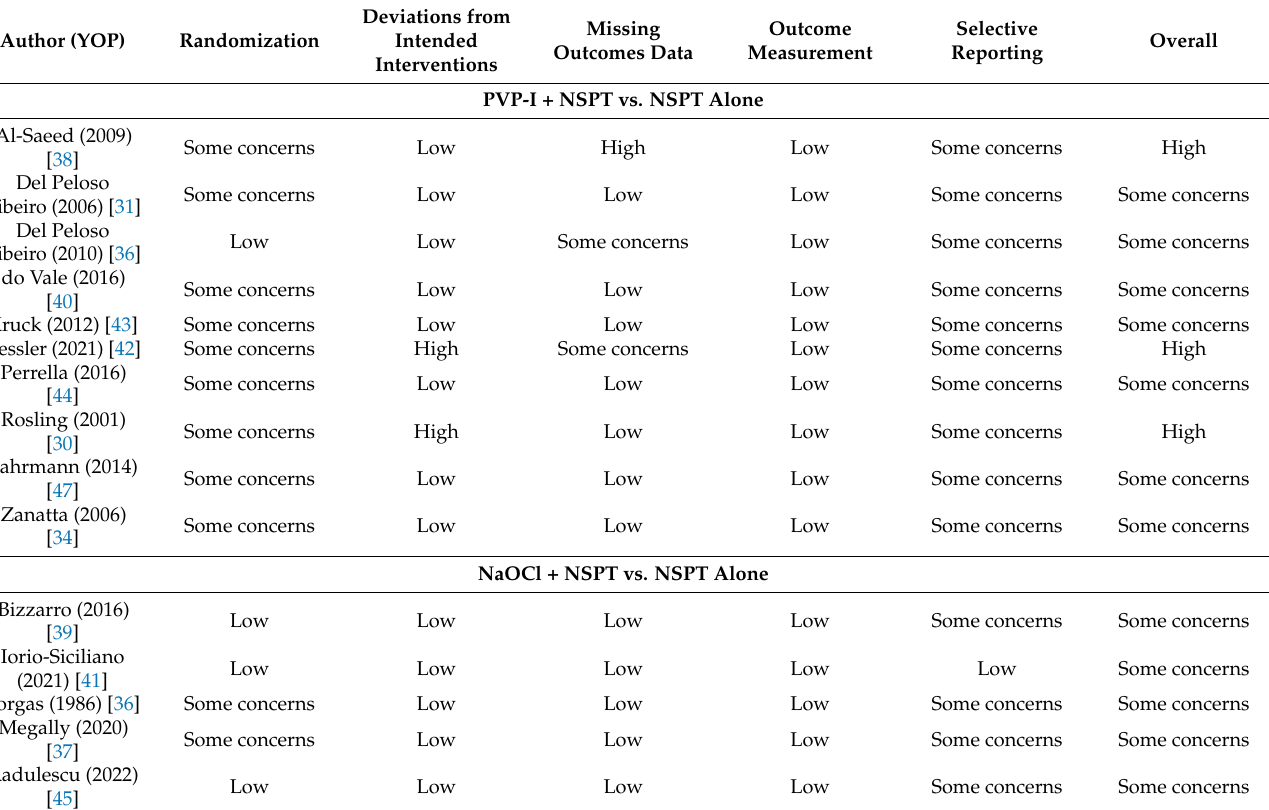
Table 2. The risk of bias of included RCTs based on the revised version of Cochrane’s risk of bias